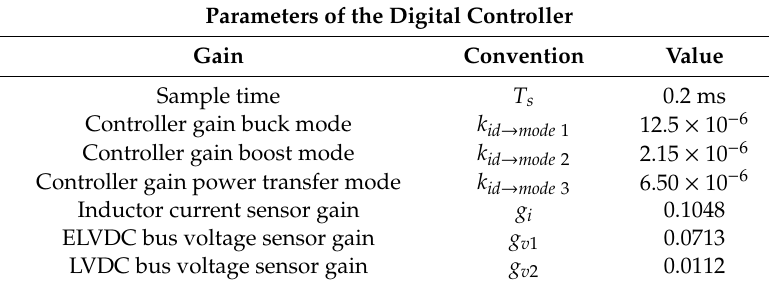
Table 2. Parameters for digital implementation of the proposed control.